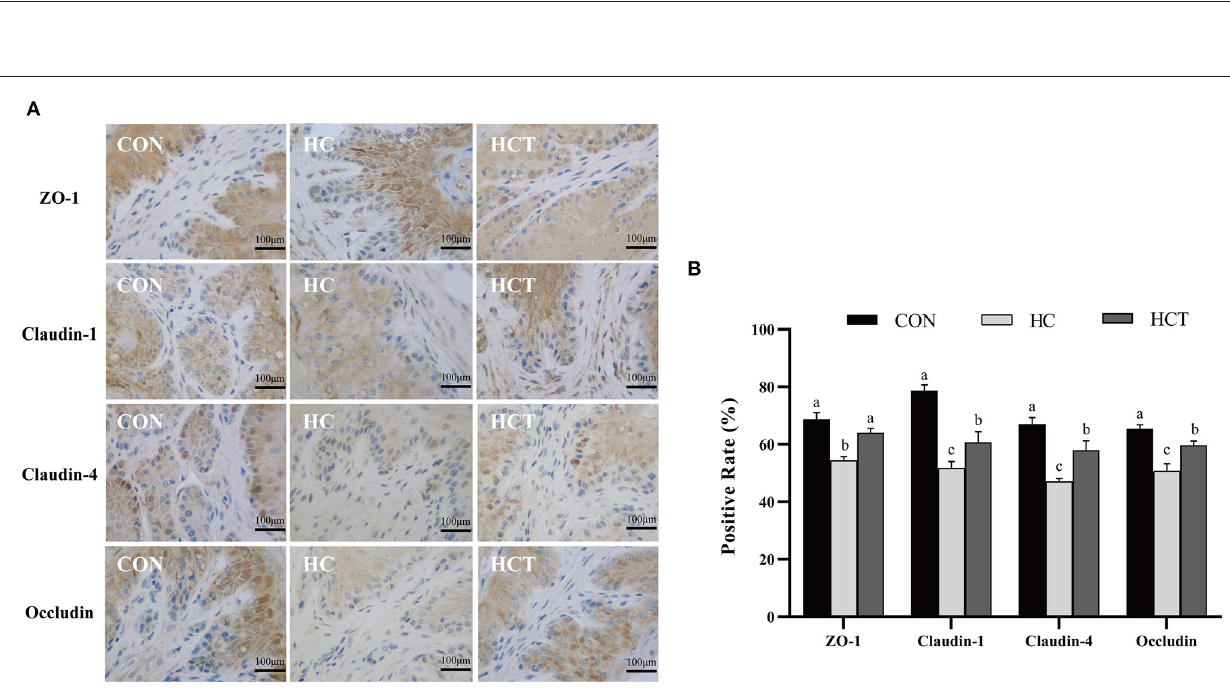
Frontiers in Veterinary Science |